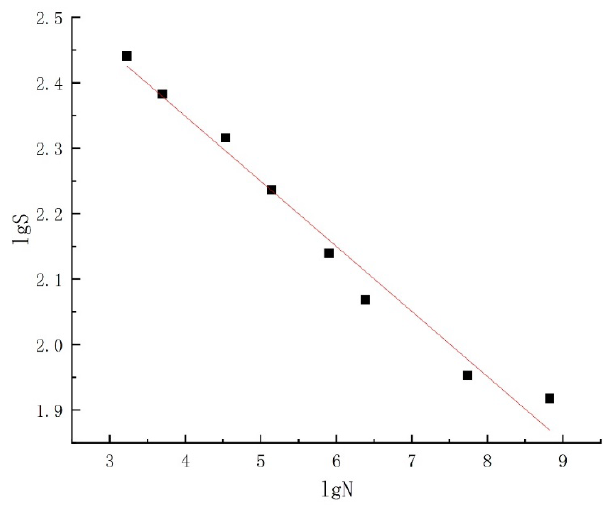
Figure 12. Fatigue life curve of 7075 aviation aluminum alloy.